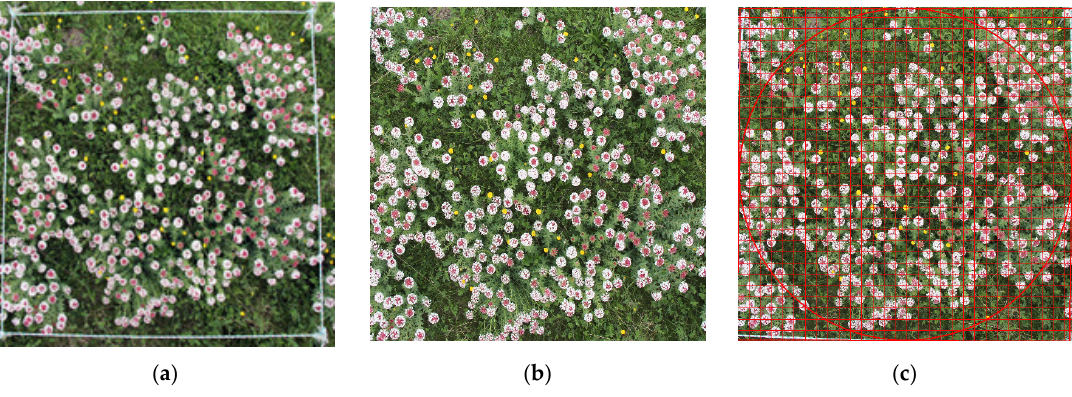
Figure 3. Coverage Interpretation of S. chamaejasme quadrat ( a ) original quadrat photo, ( b ) photo after cutting and correction, ( c ) coverage interpretation.